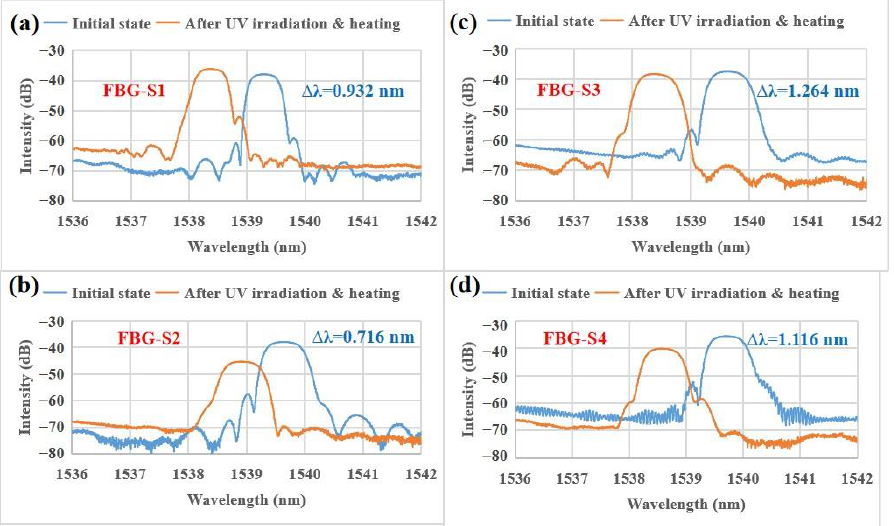
Figure 4. Spectral comparisons of the FBG strain sensors before coating and after UV irradiation and heating: ( a ) FBG-S1, ( b ) FBG-S2, ( c ) FBG-S3, ( d ) FBG-S4. The optical spectra were measured by an optical spectrum analyzer (Yokogawa AQ6370C) and the test temperature was 25.0 °C.